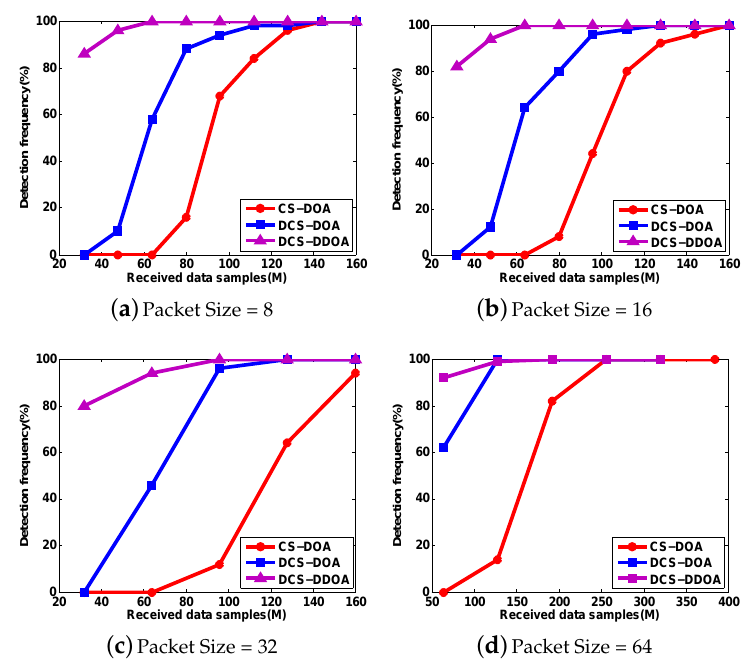
Figure 17. The comparison of detection frequency among CS-DOA, DCS-DOA, DCS-DDOA under different packet sizes.